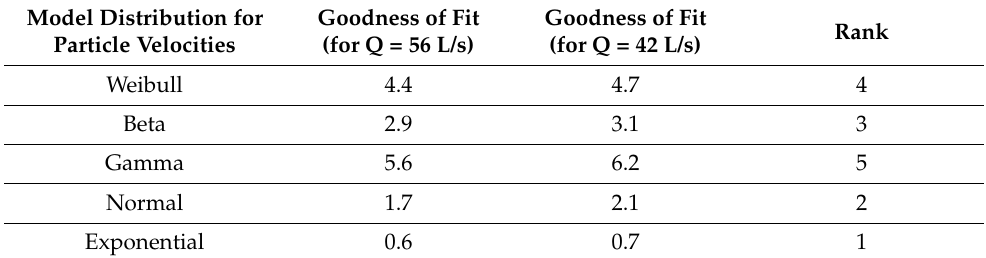
Table 3. Particle velocity goodness of fit results for minimum and maximum flow rates used in the